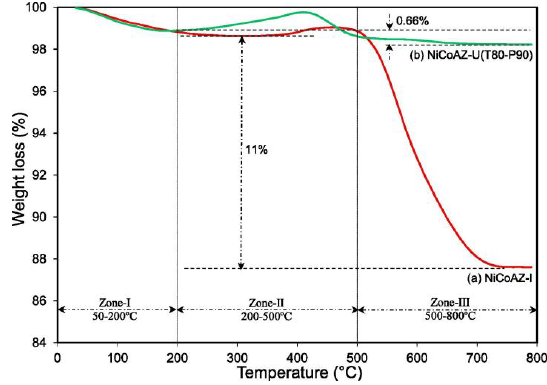
Figure 5. Thermogravimetric Analysis (TGA) profile of the spent NiCoAZ catalyst prepared using ( a ) Wet impregnation route and ( b ) Ultrasound irradiation method. Reproduced with permission from [56].